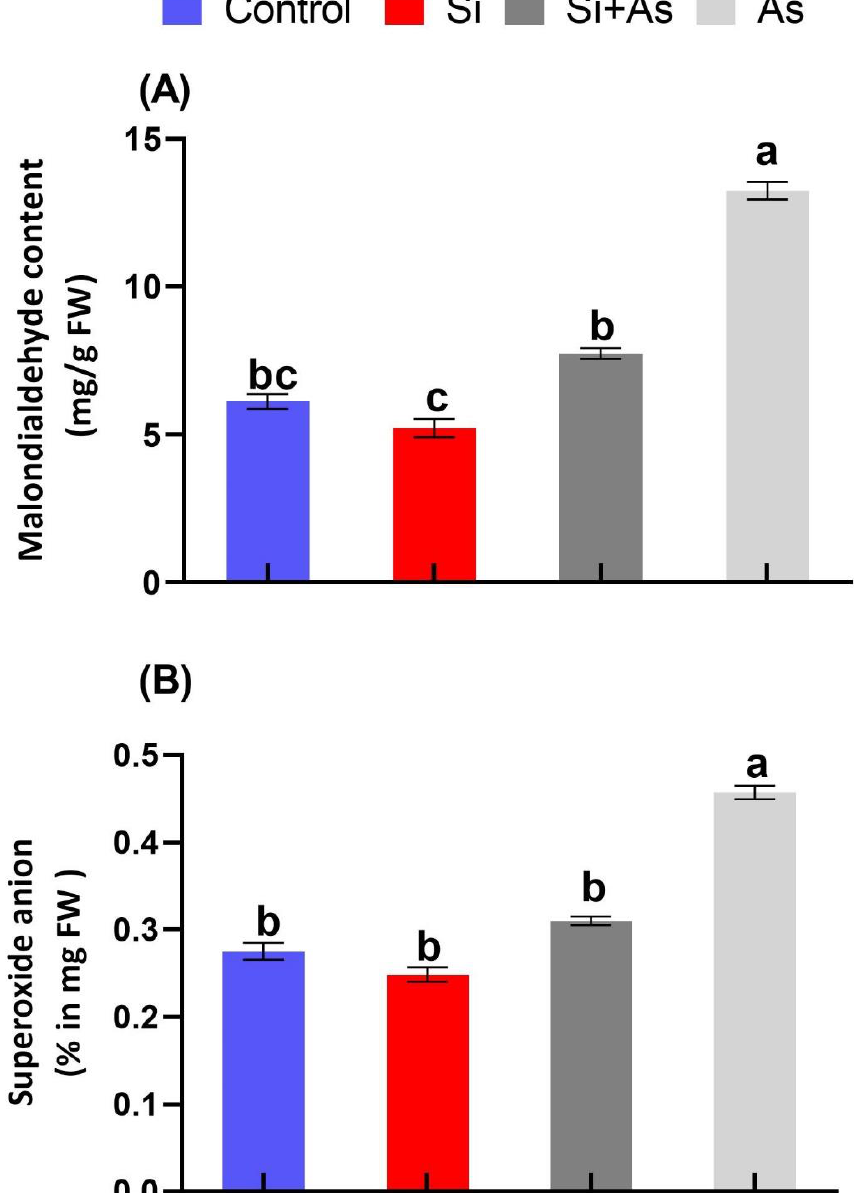
Figure 5. Stress-alleviating effects of silicon (Si) exogenously applied on ( A ) malondialdehyde (MDA) and ( B ) superoxide anion in date palm under heavy metal stress conditions. Means for all respective treatments were used to determine significant difference ( p > 0.05) via Duncan’s multiple range test (DMRT). Symbols show significant difference and values represent mean (of 4 replicates) ± standard error.